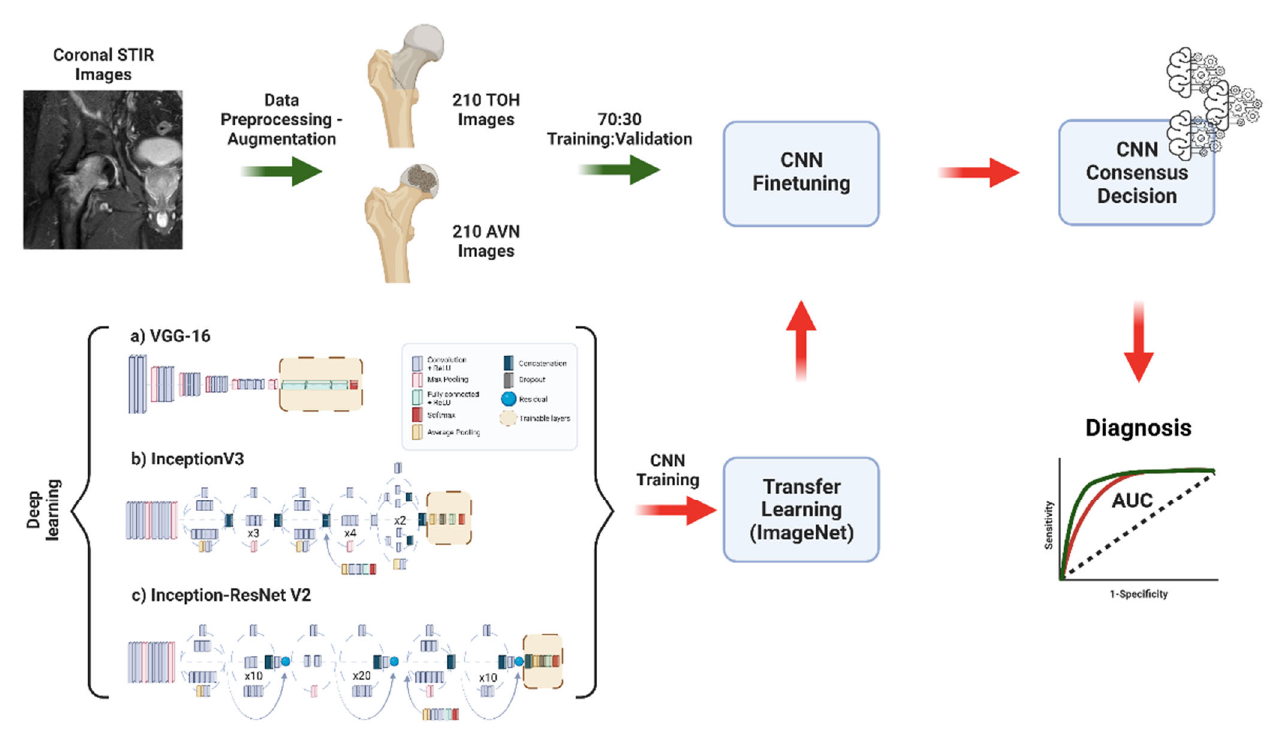
Figure 1. Flow diagram describing methodology followed for data augmentation, deep learning model training with transfer learning, and the development of a model ensemble for the diagnosis of TOH vs. AVN (created with BioRender.com).